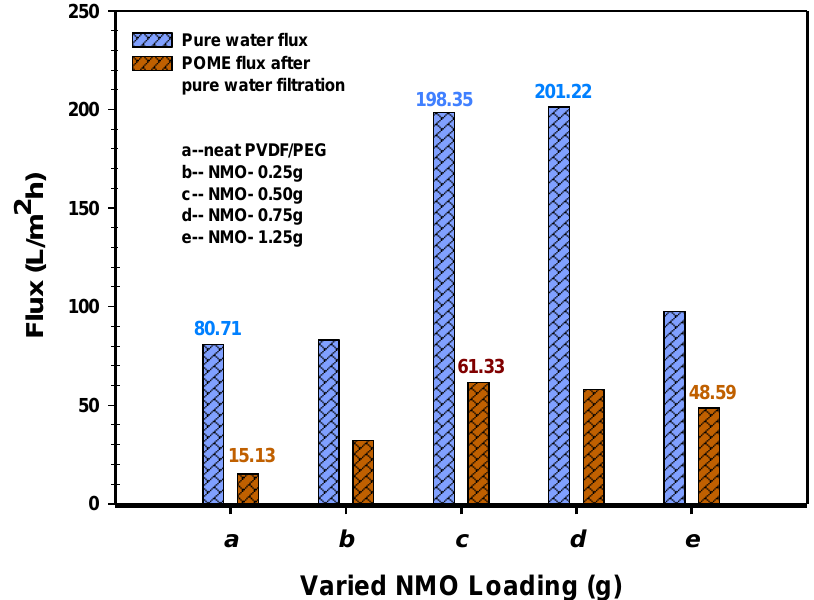
Figure 6. Flux of pure water and POME for neat PVDF-PEG ( a ), and modified Nano-hybrid fibers ( b – e